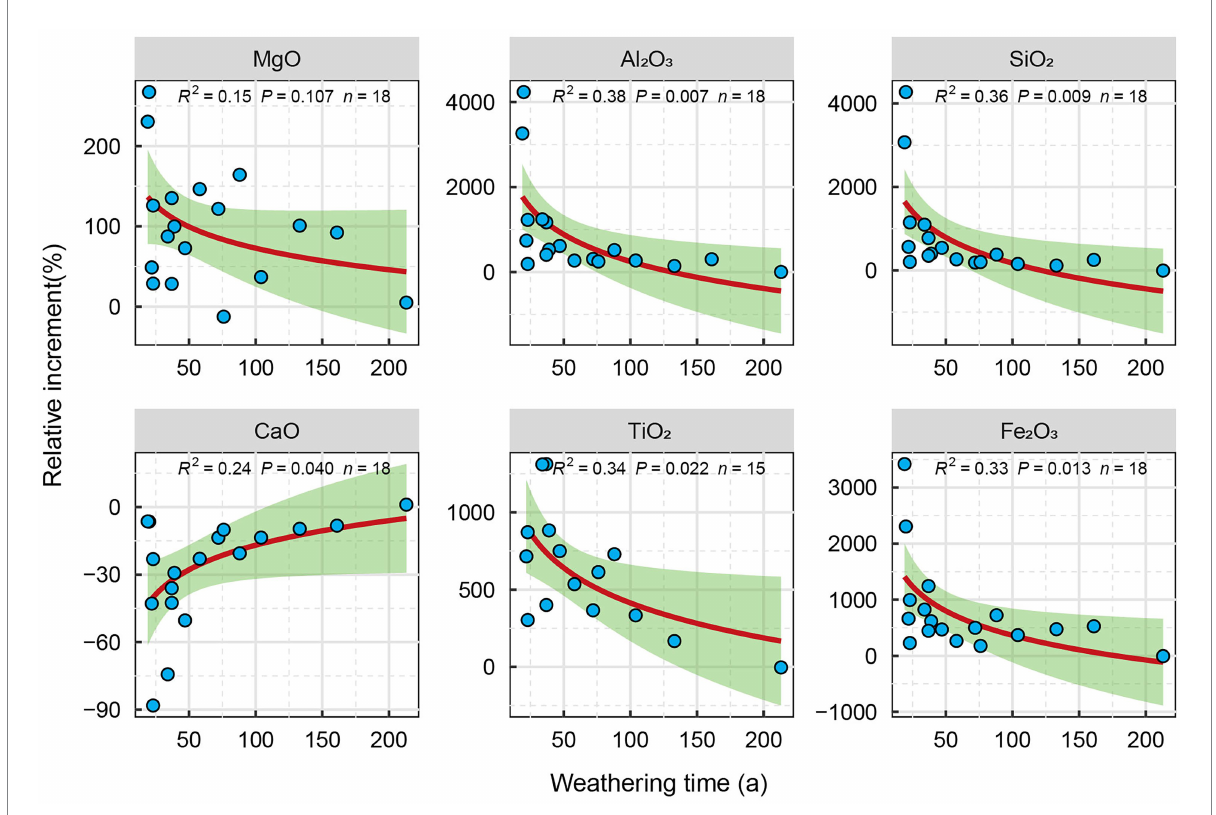
FIGURE 2 Relative variation of elements in carbonatite weathering rind with different weathering